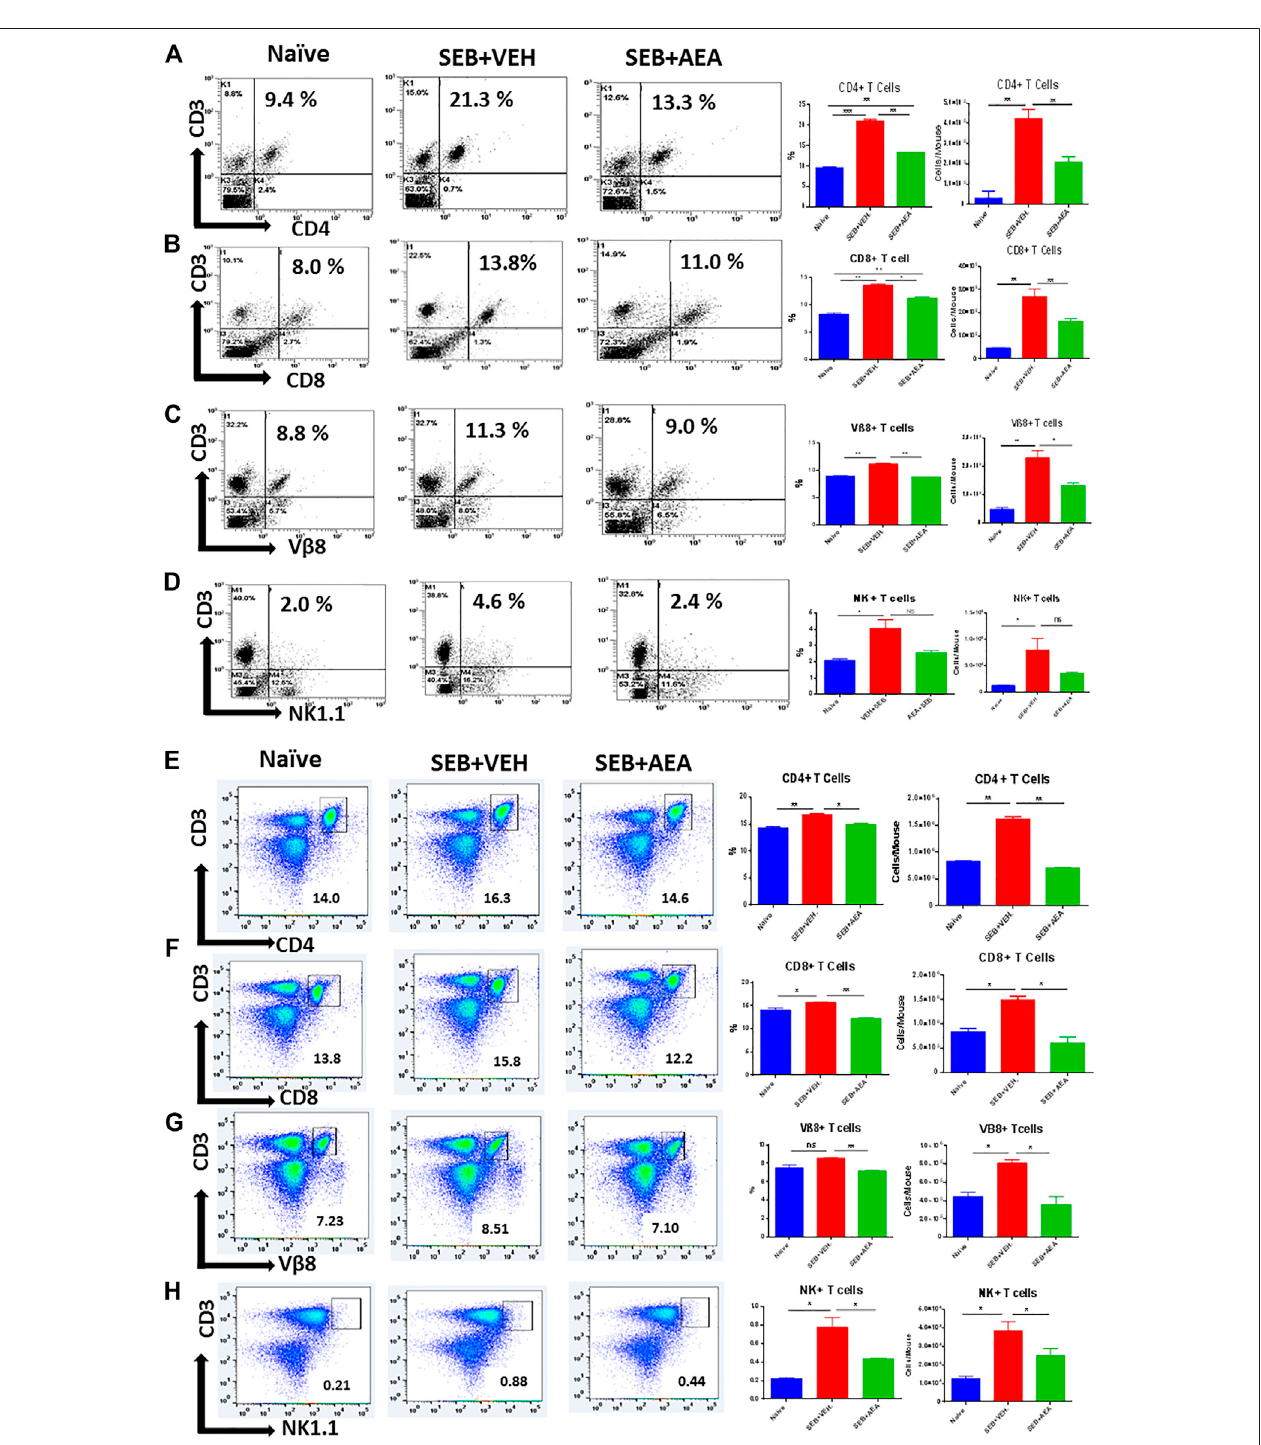
FIGURE 2 | AEA decreases T cell subpopulations in the lungs and spleens. Mice were treated with SEB and AEA as described in Figure 1 legend. Each panel shows a representative experiment depicting lung MNCs and splenocytes analyzed for various T cell markers. Data from fi ve mice/group is presented in the form of vertical bars with Mean+/-SEM. Panels A – D and E-H show data from the lungs and spleens, respectively. (A,E) CD3 + CD4 + T cells (B,F) CD3 + CD8 + T cells, (C,G) CD3+V β 8+Tcells, (D,H) CD3+NK1.1+cells.Fivemiceineachgroupwereusedandthedatawascon fi rmedinthreeindependentexperiments.* p ≤ 0.05,** p ≤ 0. 01, *** p ≤ 0.